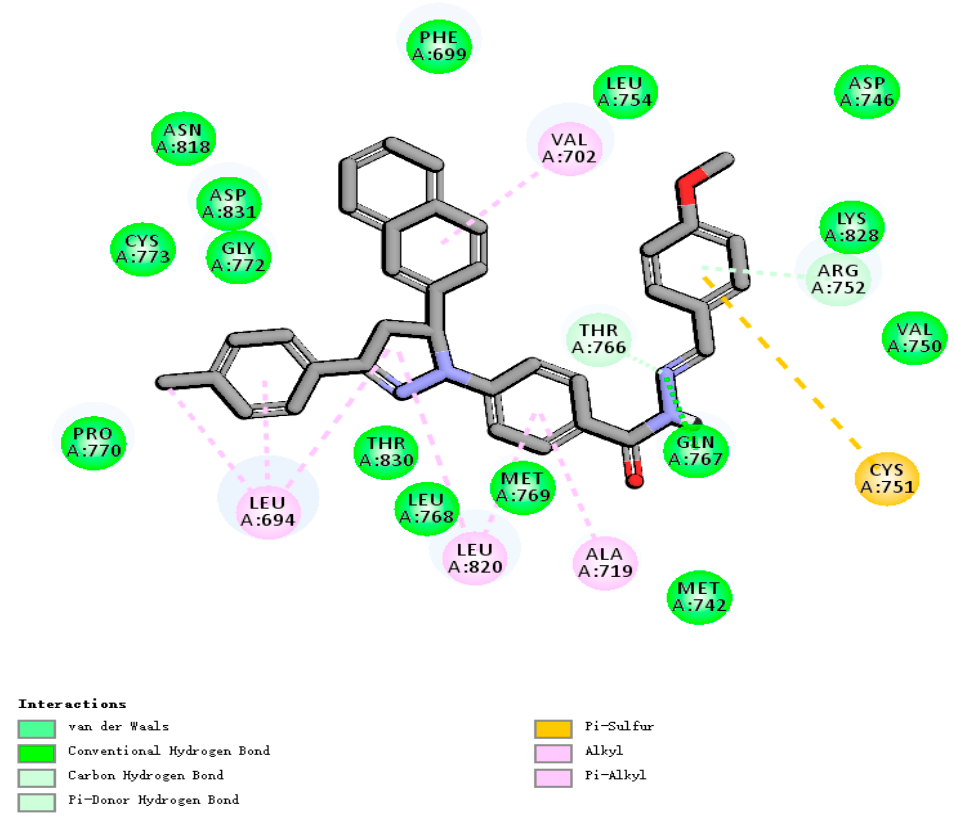
Figure 4. Molecular docking 2D model of the interaction between compound H20 and EGFR enzyme: for clarity, only interacting residues are displayed.